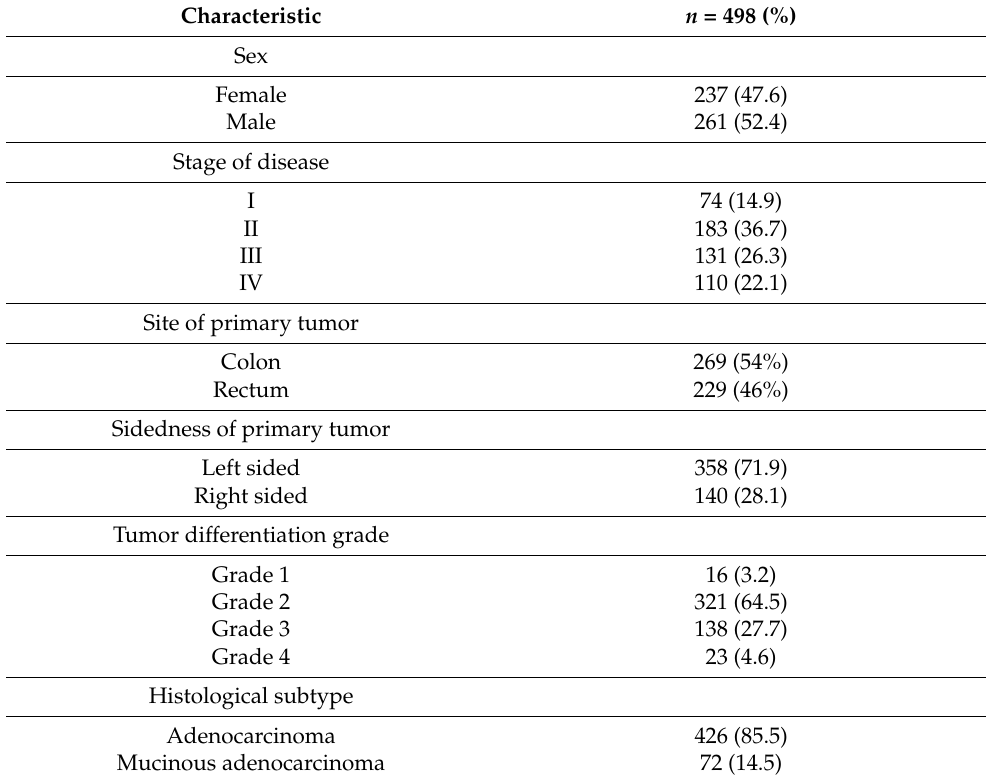
Table 2. Patient